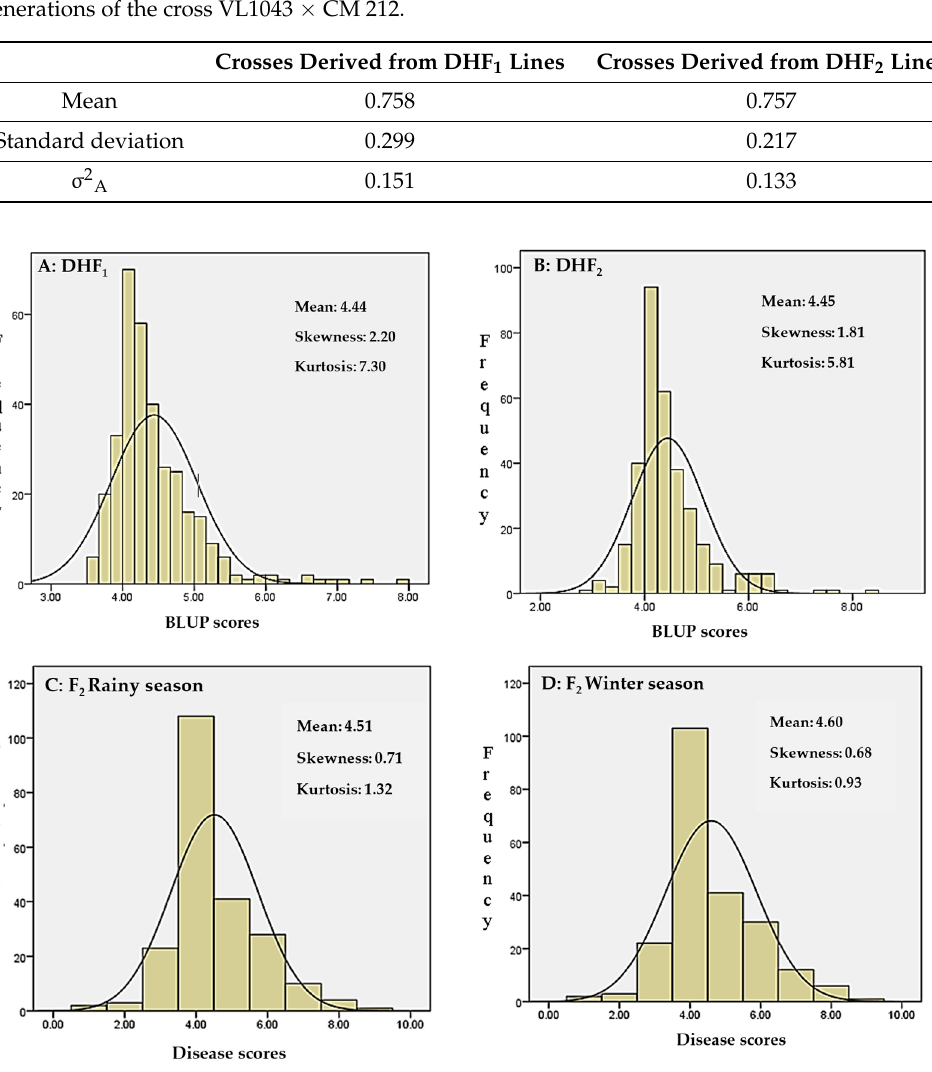
Table 8. Mean yield in testcross progenies of doubled-haploid lines produced from F 1 and F 2 gener- ations of the cross VL1043 × CM 212.